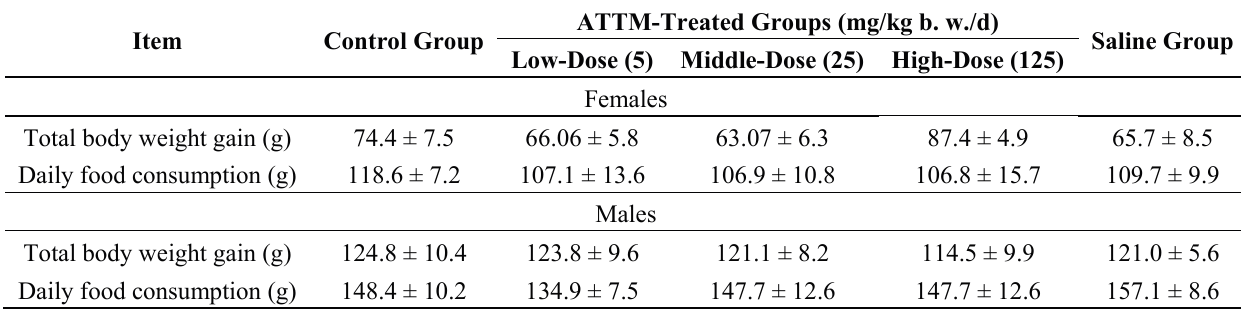
Table 3. Body weight gain and food consumption of rats orally administered ATTM for 28 days.